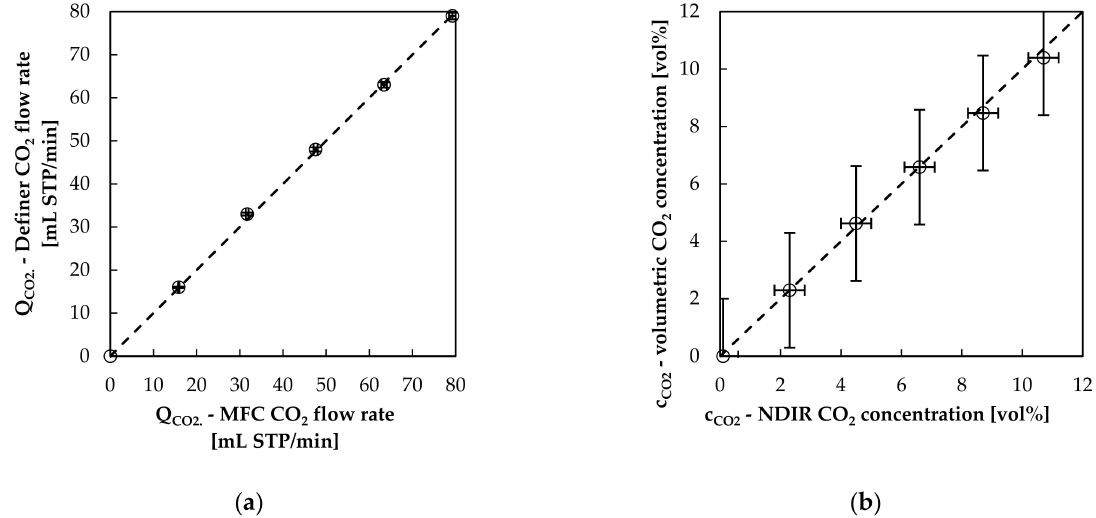
Figure 3. Comparison of ( a ) CO 2 flow rate determined with volumetric piston stroke meter and mass flow controllers (MFCs) and ( b ) CO 2 concentration determined volumetrically and with non-dispersive infrared spectroscopy